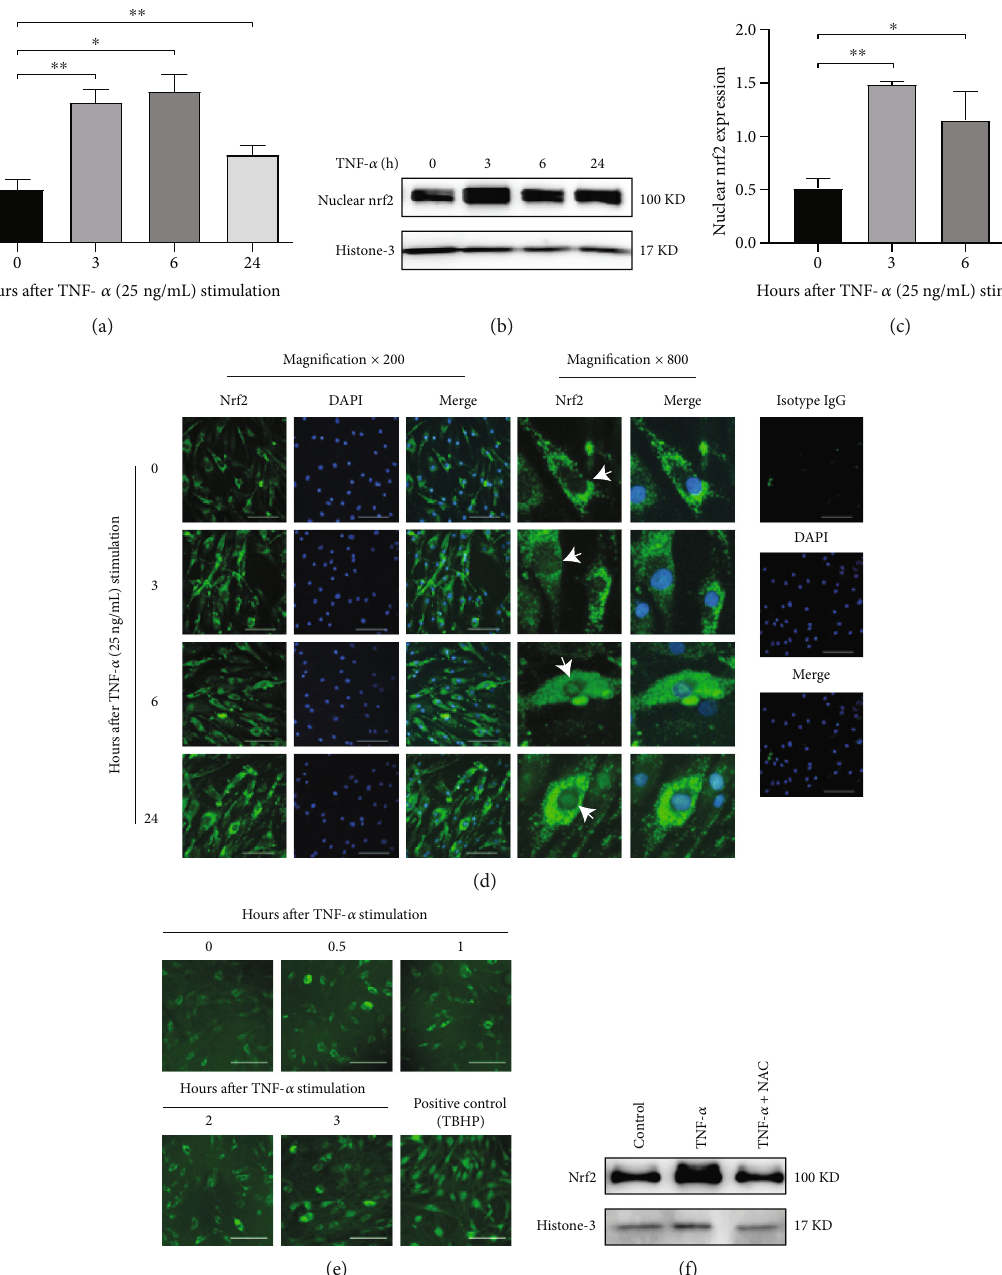
Figure 2: Induction of nrf2 expression and nuclear translocation by TNF- α through inducing ROS. The mRNA expression (a) and nuclear protein level (b, c) of nrf2 in RA-FLS were detected by real-time PCR and Western blotting after TNF- α (25 ng/mL) stimulation for 0, 3, 6, and 24h. Histone-3 was used as the housekeeping gene in Western blotting. N = 3 . (d) Nrf2 nuclear translocation (as shown by white arrows) after TNF- α (25 ng/mL) stimulation for 0, 3, 6, and 24h was examined by immuno fl uorescence staining. Representative pictures (magni fi cation × 200) from di ff erent groups and partially enlarged pictures (magni fi cation × 800) are shown. Scale bar represented 50 μ m. (e) Intracellular ROS levels in RA-FLS stimulated with TNF- α (25 ng/mL) for 0, 0.5, 1, 2, and 3 h and tert-butyl hydroperoxide (TBHP, 50 μ M) (positive control) for 3 h were detected using DCFDA probe. Scale bar represented 100 μ m. (f) The nuclear protein level of nrf2 in RA-FLS after TNF- α (25 ng/mL) stimulation for 3 h with or without N-acetylcysteine (NAC, 5 μ M) pretreatment for 1 h was detected by Western blotting. Histone-3 was used as the housekeeping gene. Data were shown as the mean ± SD ; ∗ p < 0 : 05 and ∗∗ p < 0 : 01